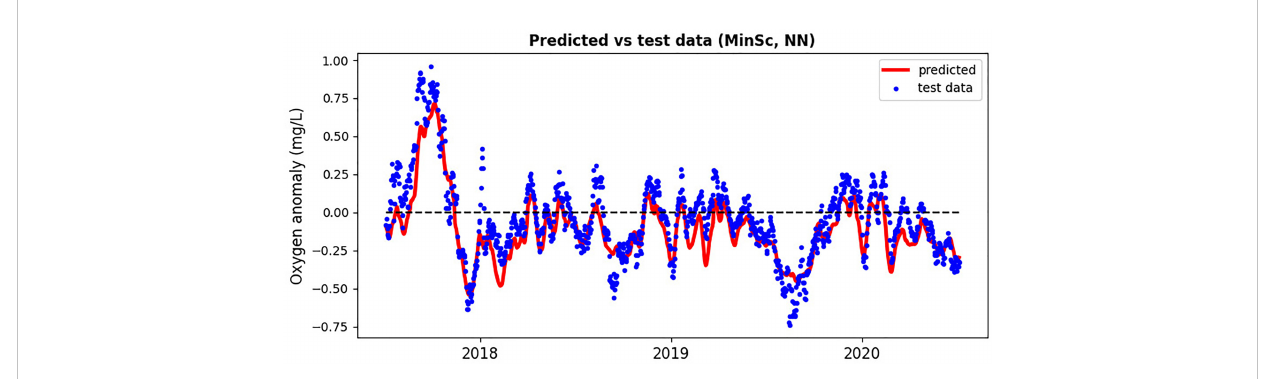
FIGURE 5 Neural network based on SST inputs predicting the surface oxygen anomaly at the GB location compared with the test data-set from 2018-2020.